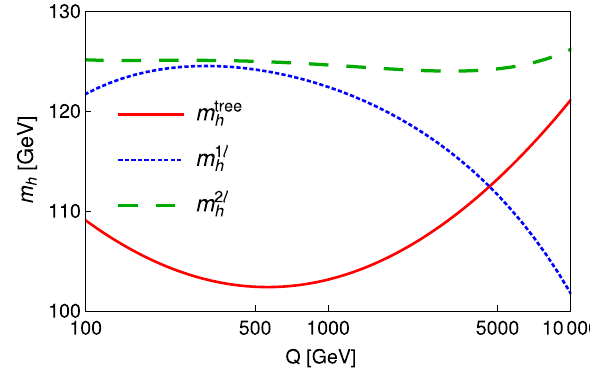
Fig. 6 Lightest Higgs mass m 2 as a function of the renormalisation h scale Q , taking into account the running of all parameters with the RGEs included in SPheno . Red curve: tree level; Blue dot-dashed curve: one-loop order; Green dashed curve: two-loop